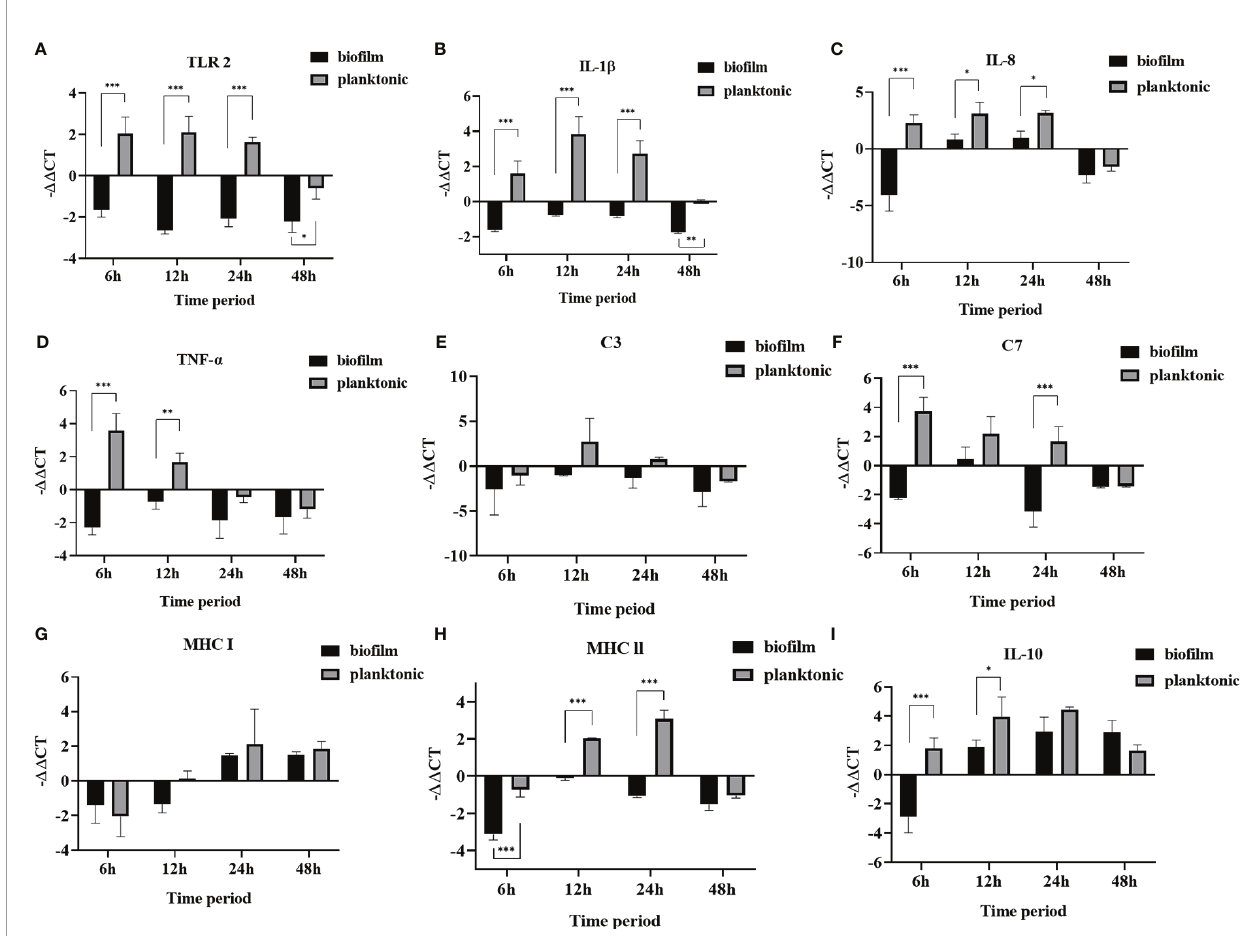
FIGURE 6 | The relative expression levels of immune genes in mullet spleens after infection with planktonic and bio fi lm Lactococcus garvieae . (A) TLR 2 , (B) IL-1 b , (C) IL-8 , (D) TNF- a , (E) C3 , (F) C7 , (G) MHC I , (H) MHC II , (I) IL-10 . Data are presented as mean ± standard deviation. p -values were calculated by two-way ANOVA ( p <0.05*, p < 0.01**, p <